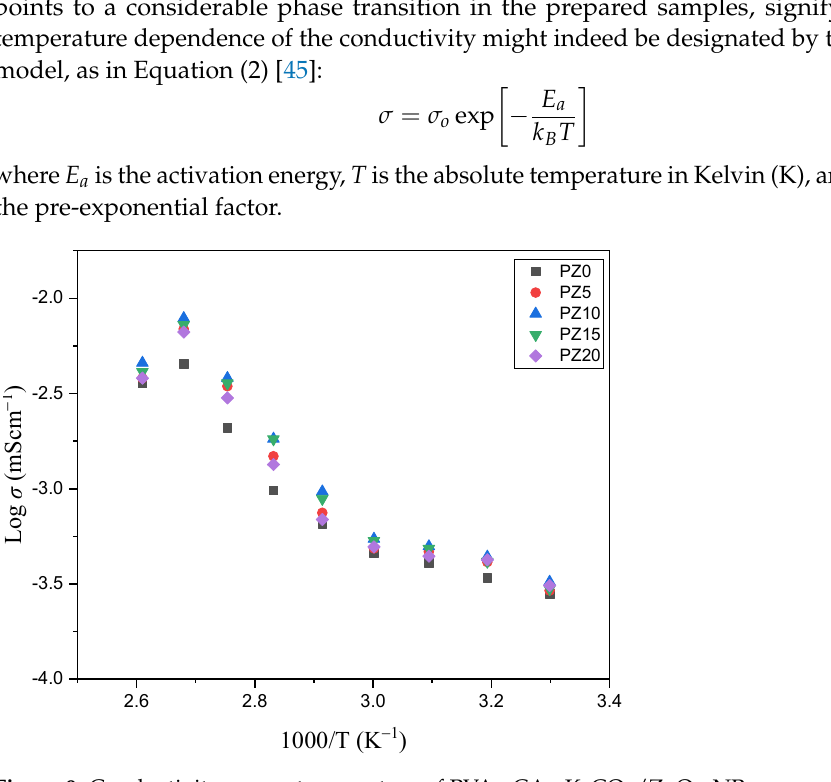
Figure 9. Conductivity versus temperature of PVA−CA−K 2 CO 3 /ZnO−NPs composite SPEs. Accordingly, an expansion of the polymers due to the polymer segmental motion at higher temperatures generates vacancies where the ions easily flow. Consequently, the mobility of ions improves and the ion cloud effect at the electrode–electrolyte interface is reduced. Equally, with the increase in temperature, the chain of the polymer grows a faster internal mode that causes segmental motion due to bond rotation. Therefore, the inter- chain ion hopping is preferred, which leads to the increase in conductivity with the tem- perature [64,65]. At temperatures above 373.15 K, nevertheless, the conductivity of the samples was shown to decrease. This reduction could be ascribed to the formation of ele- ments inside the polymer matrix, which limits ion hopping and hence results in increased resistance in the majority of the samples [66,67]. 3.2.4. Activation Energy ( E a ) To study the dynamic motion of ions in the prepared polymer electrolytes, the acti- vation energy ( E a ) of all the samples was computed and analyzed by fitting it into the Arrhenius Equation (2) [30]. The results and values of E a of all the samples are shown in Figure 10 and Table 4, where the maximum conducting sample (PZ10) is found to have the lowest activation energy, which indicates that it is inversely proportional to the ionic conductivity. It shows that incorporation of ZnO nanofiller into the PVA–CA–K 2 CO 3 com- posite tends to decrease the potential energy barriers for the ion migration, resulting in the decrease in activation energy [30]. Furthermore, the addition of fillers into the electro- lyte was found to disturb the coordination within the backbone of the polymer and con- sequently needs less energy to break and form coordination bonds within the matrix of the polymer hosts. Thus, the diffusion of ions is promising, and this further enhanced the conductivity [16]. As reported previously, low E a is due to the tiny space within the transit sites delivered by the polymer blend. This result is similar to a large body of past research on various polymer electrolytes [13,30,46,66].